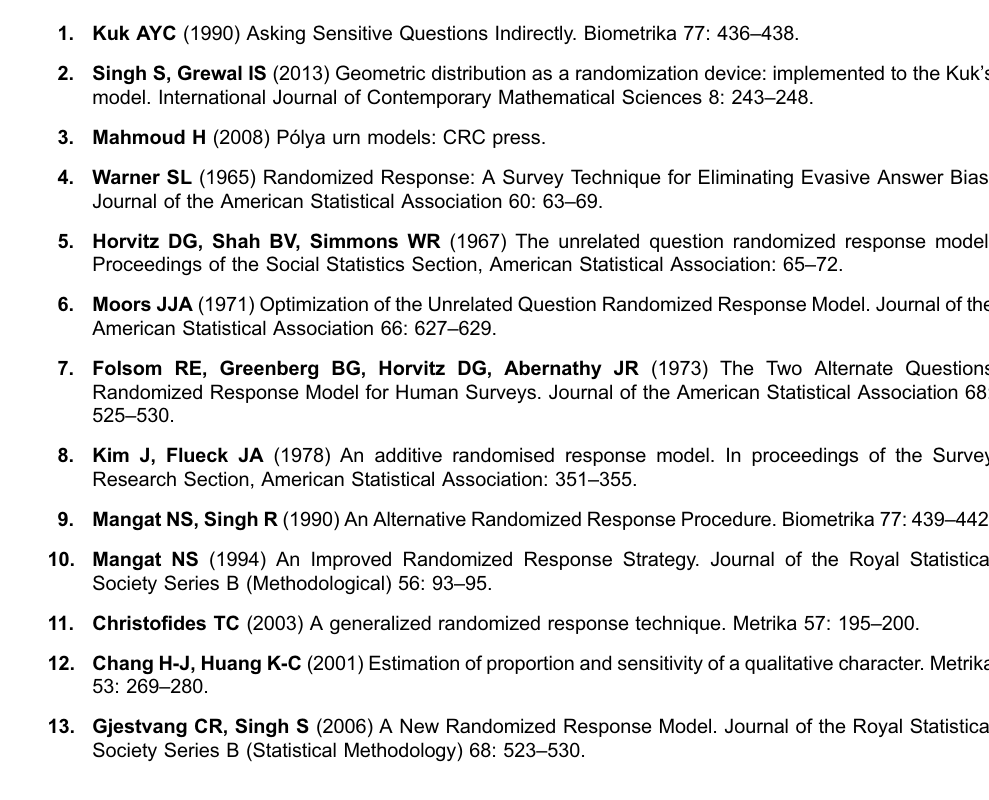
~ r ~ 1 , with respect to ^ p for n 2 SG 1 1 ~ n ~ 3 , c ~ c ~ 1 , 2 2 1 2 ~ 0 : 7 , h ~ 0 : 3 . 1 2 ~ 0 : 3 , h (cid:2) ~ 0 : 7 1 2